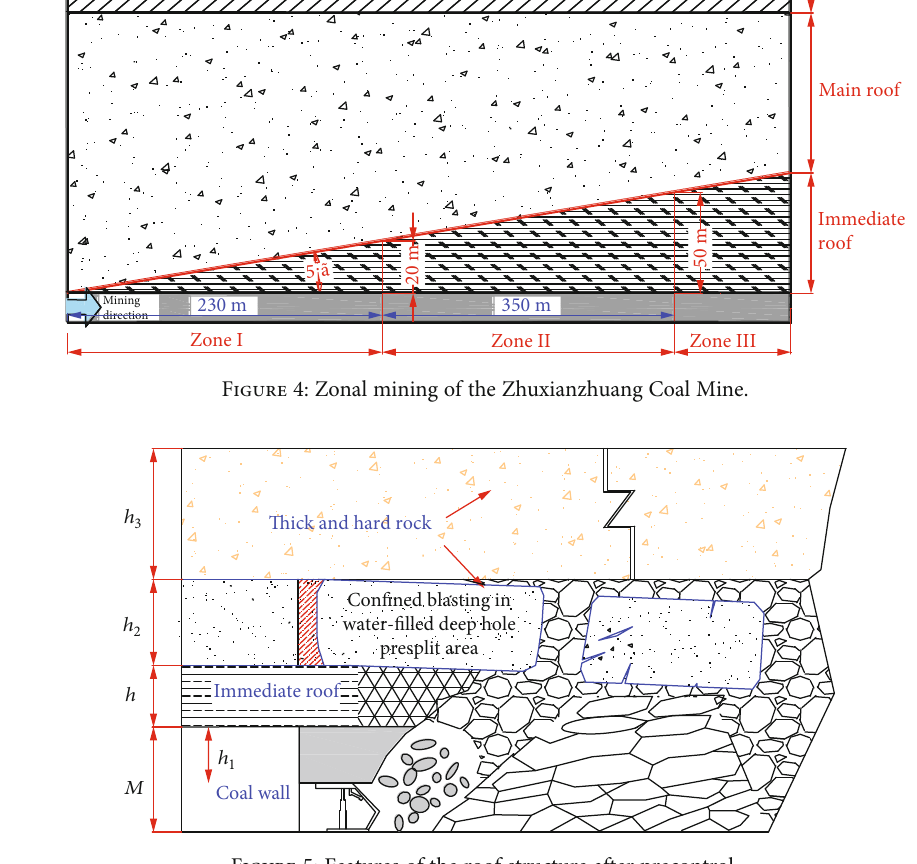
Figure 5: Features of the roof structure after precontrol.